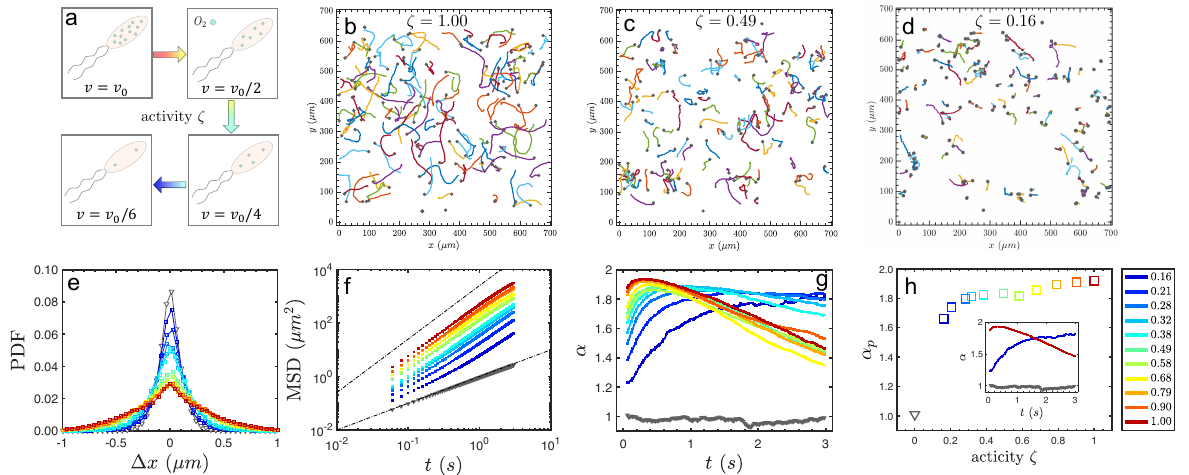
Figure 3. ( a ): Schematic activity decaying is reflected by bacterial velocity. ( b – d ): Typical trajectories of tracer particles in bacterial turbulence at different activities, with a black dot as the starting point for each trajectory. ( e , f ): Probability density function of the displacement in x-direction ∆ x at ∆ t = 1/50 s, and MSD= < ∆ x 2 ( t ) > of tracer versus lag time t , by varying activity (in color). ( g ): Apparent superdiffusion exponent α p calculated from the slope of time dependence, and ( h ) as a function of activity ζ